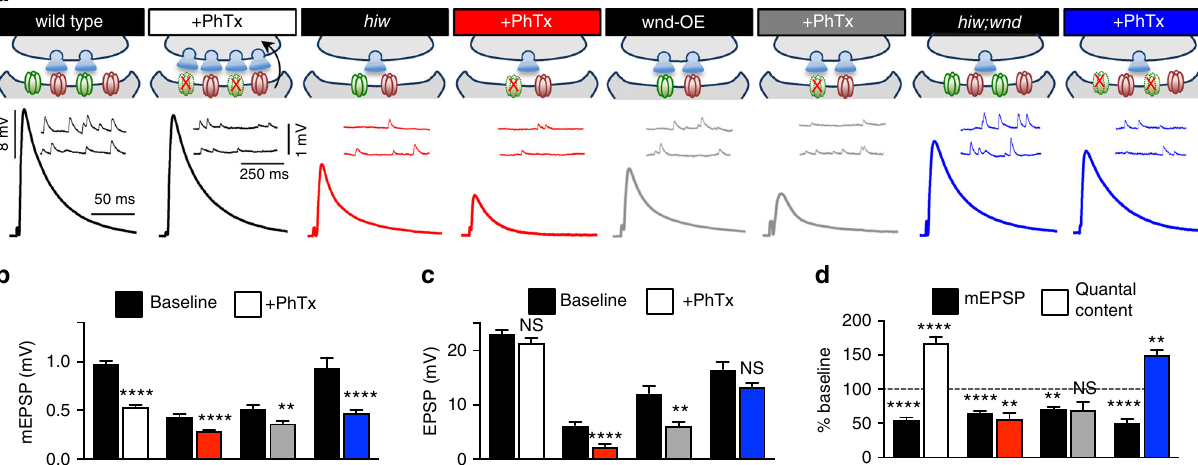
Fig. 4 PHP is not expressed in hiw mutants or wnd-OE following acute postsynaptic GluR perturbation. a Schematic and representative EPSP and mEPSP traces of indicated genotypes before (baseline) and following PhTx application. Quanti fi cation of mEPSP ( b ) and EPSP ( c ) amplitude in the indicated genotypes and conditions. Note that while PhTx application causes a reduction in mEPSP amplitudes in all genotypes, only hiw mutants and wnd-OE fail to maintain baseline EPSP amplitudes. d Quanti fi cation of mEPSP and quantal content values normalized to the same genotype in the absence of PhTx (baseline). No increase in presynaptic neurotransmitter release (quantal content) is observed in hiw + PhTx or wnd-OE + PhTx, demonstrating that PHP fails to be acutely expressed in hiw mutants, but is restored in hiw;wnd double mutants. Error bars indicate ± SEM. For statistical signi fi cance, an unpaired t